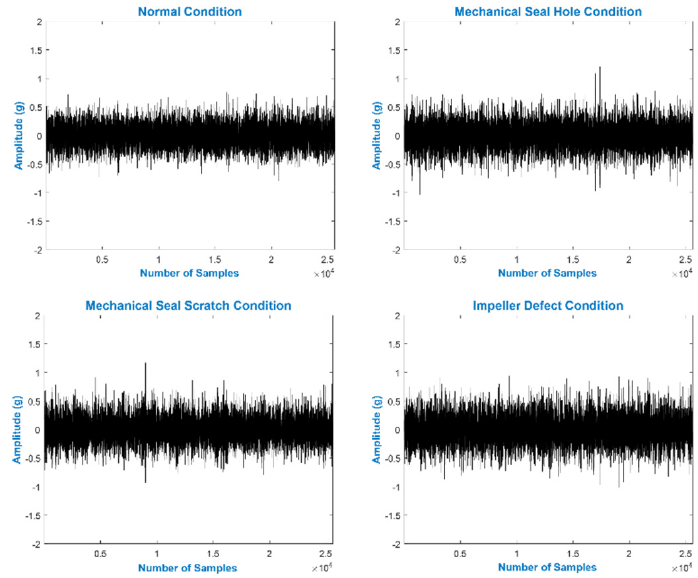
Figure 4. VS of the MCP under NC and defective conditions.